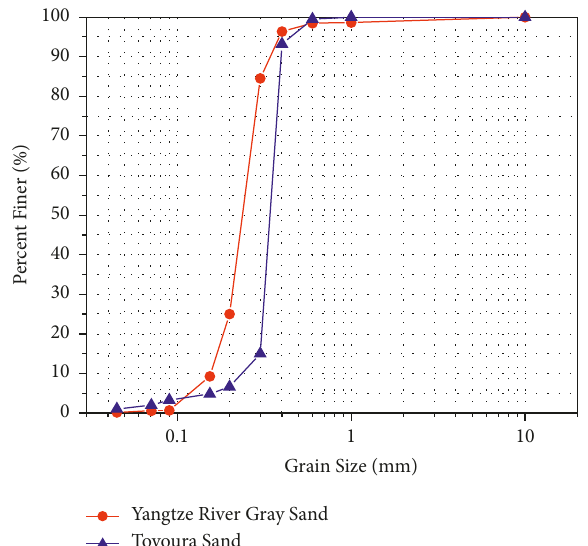
Figure 2: Grading curve of the Yangtze River gray river